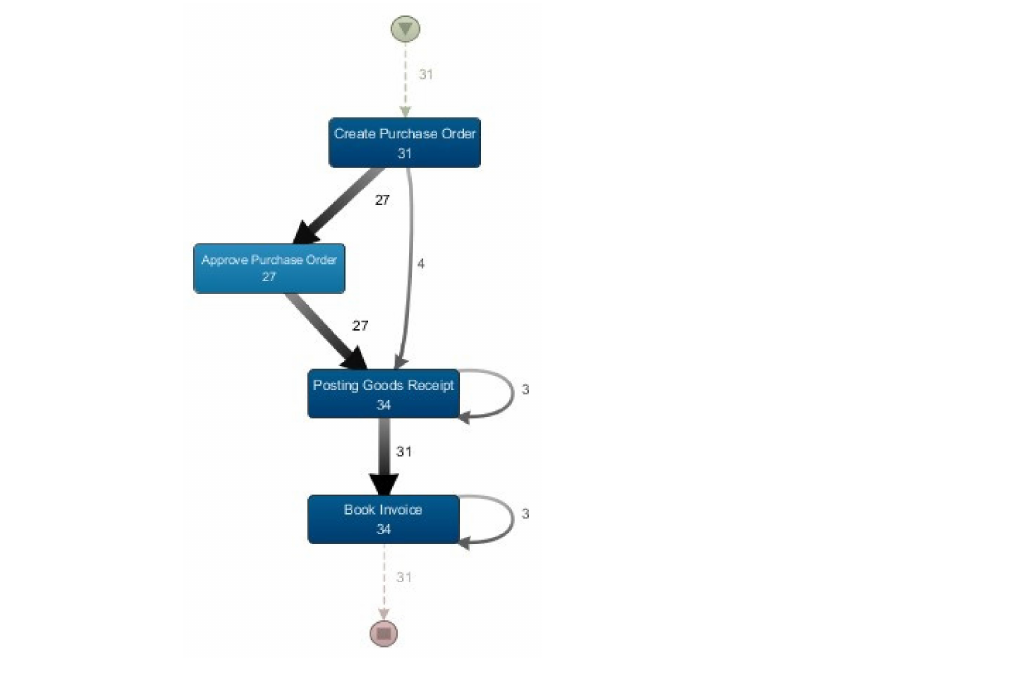
Figure 7. Discovered process model from the generated XES